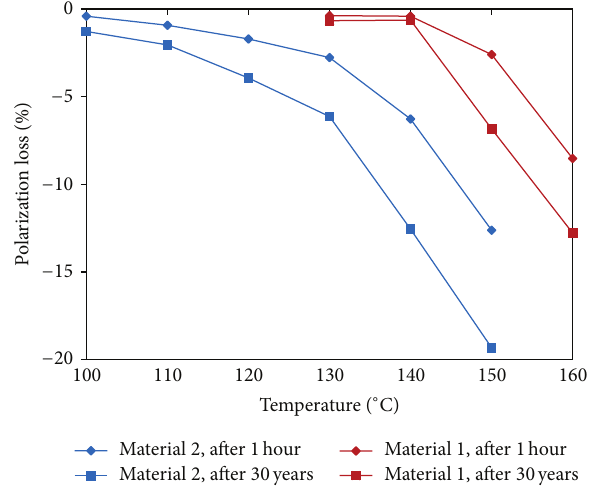
Figure 6: Estimated polarization losses after 1 hour and after 30 years as a function of exposure temperature in open-circuit exposures. The curves on the left refer to material 2 and the curves on the right to material 1.